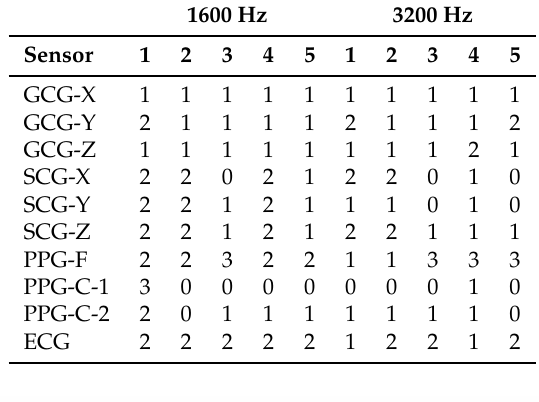
Table 3. Bin width parameter m ∗ for each of the five subjects.